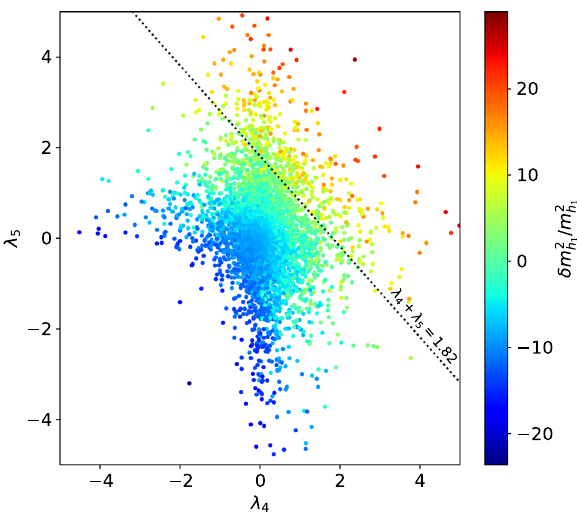
/ m 2 intheTRSMshownasascatterplotinthe h 1 h 1 = 125 . 09GeV,130GeV ≤ m h 1 ,v ≤ 1 . 2 1 2